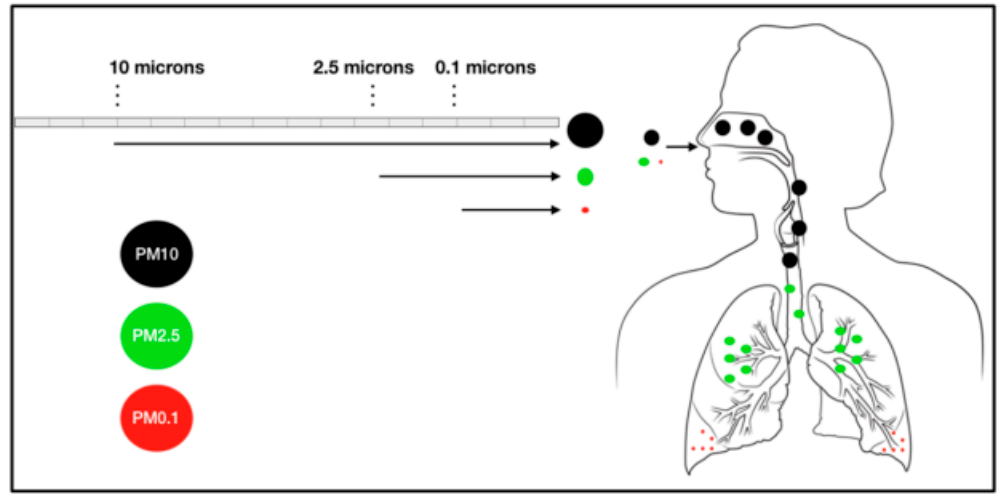
Figure 1. Classification of particulate matter according to aerodynamic diameter. The smaller the particles, the further the penetration and the worse the impact on health. As PM enters into our body upon inhalation, coarse PM or PM10 with a diameter of less than 10 µ m is retained in nasal cavities and upper airways, whereas fine PM or PM2.5 with a diameter of less than 2.5 µ m and ultrafine PM or PM0.1 with a diameter less than 0.1 µ m might travel deeper into lungs and bronchi alveoli, and even invade to further organs or elicit systemic effects through the circulation.